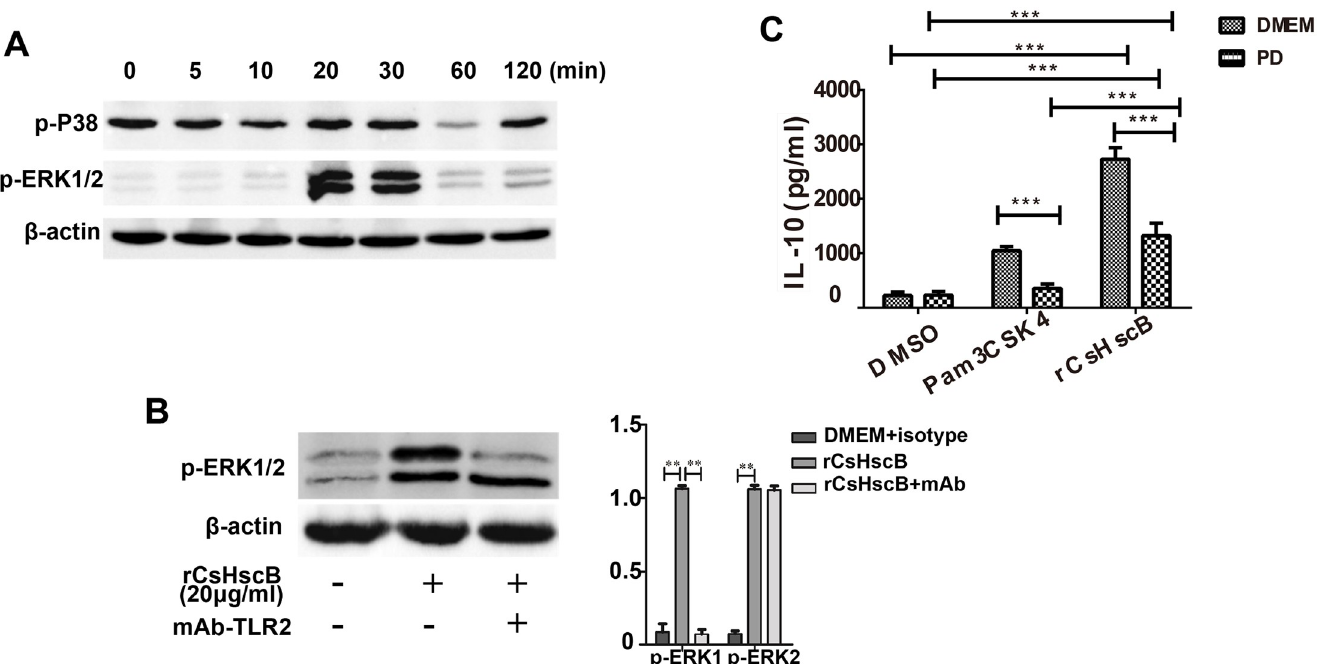
Fig 4. rCsHscB-induced IL-10 production partly depends on TLR2-mediated phosphorylation of ERK1/2 in RAW 264.7 cells. (A) ERK1/2 but not p38 MAPK was activated in rCsHscB-stimulated RAW 264.7 macrophage for 20~120 min detected by western-blot. (B) phosphorylation of ERK1 but not ERK2 was attenuated in rCsHscB-stimulated cells when TLR2 was blocked by neutralizing antibody determined by western-blot. (C) ELISA analysis of IL-10 production in rCsHscB- stimulated RAW 264.7 cells the presence or absence of ERK1/2 inhibitor (PD98059). Quantitative data are representative of mean ± SEM of at least three independent experiments (n = 4). � P < 0.05, �� P < 0.01, and ��� P < 0.001 compared with indicated